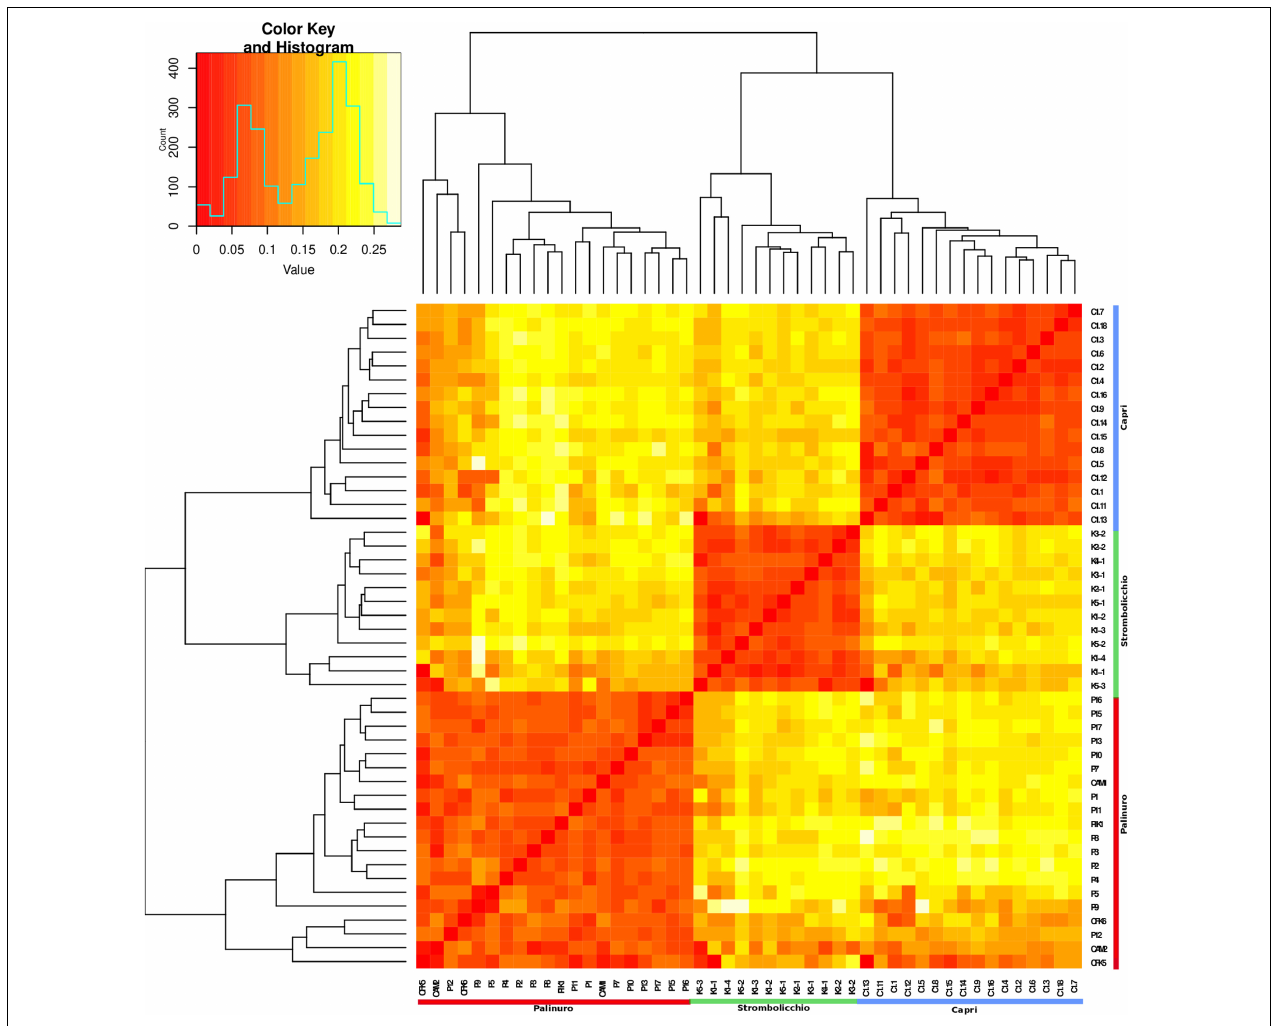
FIGURE 4 | A heatmap graph of Fst was built by using 3,962 SNPs across 48 individuals (SNPs present in at least 70% of individuals). The heatmap illustrates the Fst pairwise matrix based on a color code: orange/red color (low Fst) to white (high Fst). Along the axes of the matrix, phylogenetic trees are constructed using the Neighbor Joining method. The legend (top left) depicts the color-coded Fst